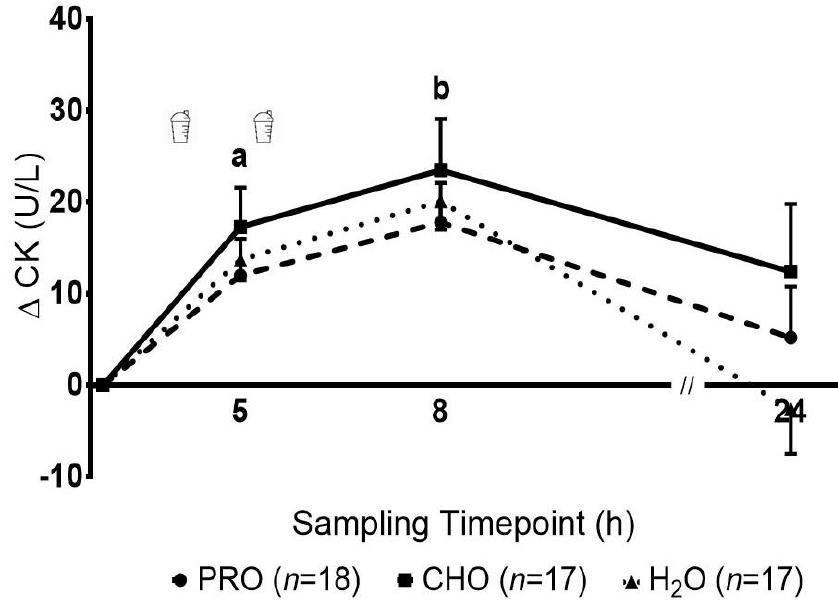
Figure 3. Changes in the plasma concentrations of creatine kinase (CK) following intense swimming in adolescent swimmers. a—indicates a significant increase ( p < 0.016) at 5 h compared to baseline and 24 h in all groups. b—indicates a significant increase ( p < 0.016) at 8 h compared with all other timepoints in all groups.